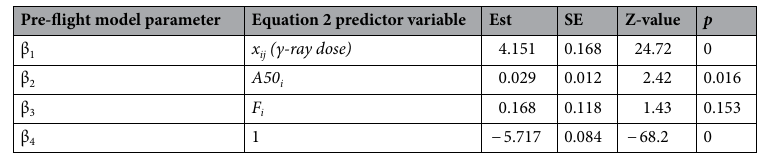
Table 1. Pre-flight Ex Vivo poisson regression parameter estimates (“Est.”) and standard errors (“SE”) based on all pre-flight observations with dose ≤ 0.5 Gy. The “Z”-value is the signal-to-noise ratio (Est/SE), while “p” is the p value for the test of the null hypothesis that the parameter is zero. In the fitted model, mean log CAR increases by about 0.0415 (4.151/100) per cGy of gamma radiation, corresponding to about a 4% increase in median CAR per cGy of increased radiation. Similarly, all other things being equal, median background CAR increases by about 3% per year of age. There could also be a gender effect, but there were not enough female subjects to accurately estimate it. Results presented in this and the other tables were generated using Stata Statistical Software 27 .